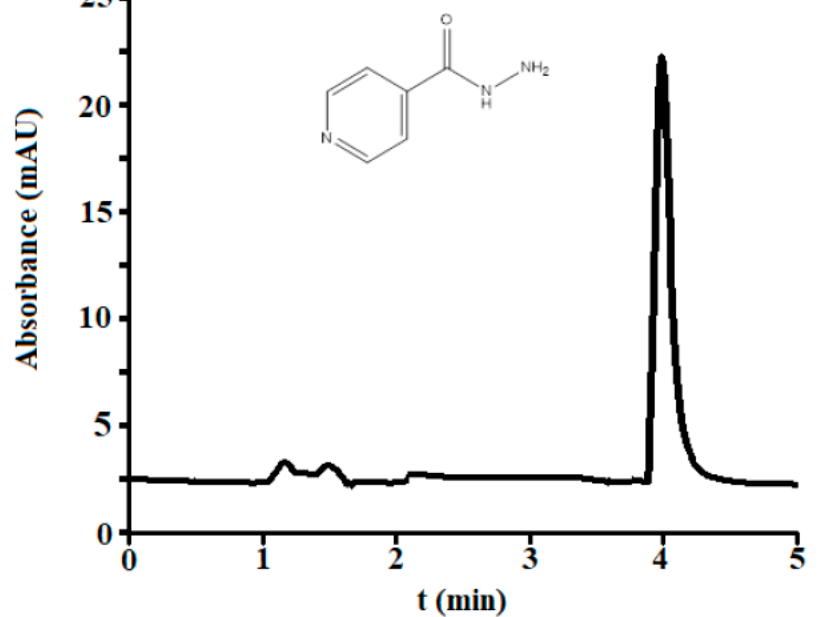
Figure 1. Chromatogram of standard isoniazid (1 µ g/mL) obtained under the optimal conditions. Structure of isoniazide (MW = 137 g/mol).